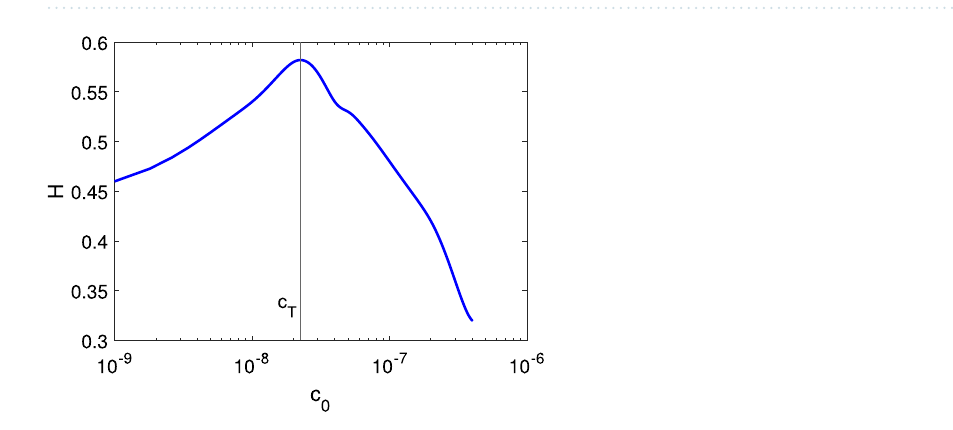
Figure 4. Distance travelled by leading font for different initial cell concentrations at time t = 5 . Here β = 0.97 and δ = 0.952 . Other parameter values are given in Table